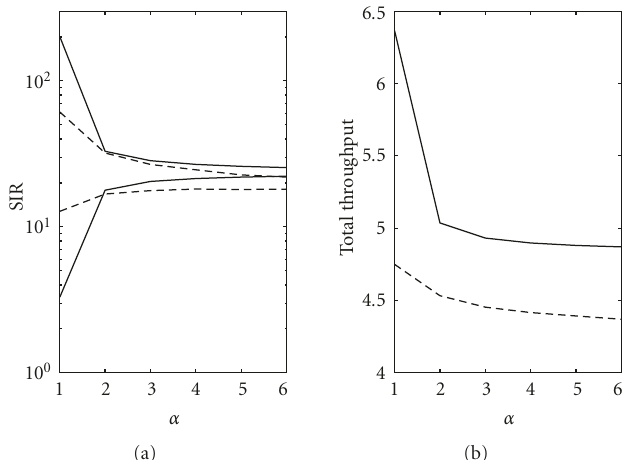
Figure 4: Maximum and minimum SIR (a), throughput (b) over α for utility-based power control (dashed lines) and utility-based joint power and receiver control (solid lines).